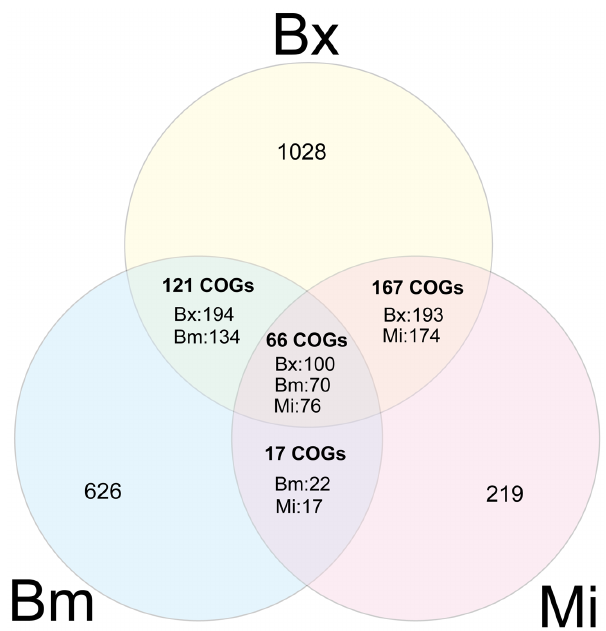
Figure 3. Venn diagram showing the distribution of shared gene families among the nematode secretomes. Bold numbers indicate the clusters of orthologous groups (COGs). Non-bold numbers indicate the genes in each cluster. Bx: Bursaphelenchus xylophilus ; Mi: